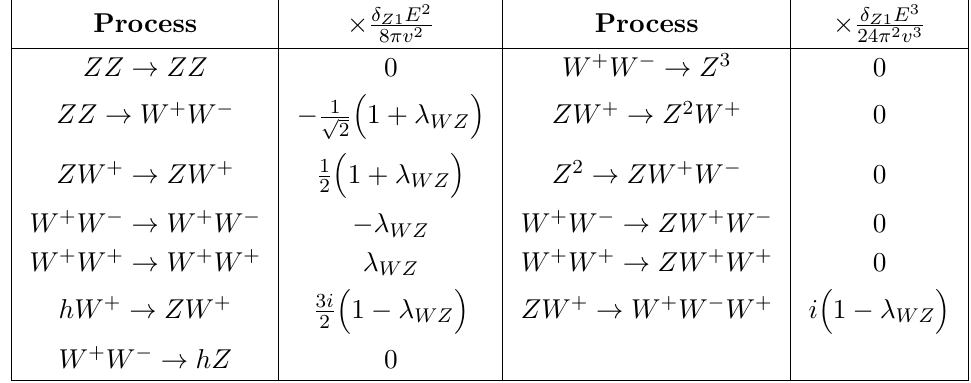
Table 3 . 4-body and some 5-body unitarity-violating processes without assuming custodial